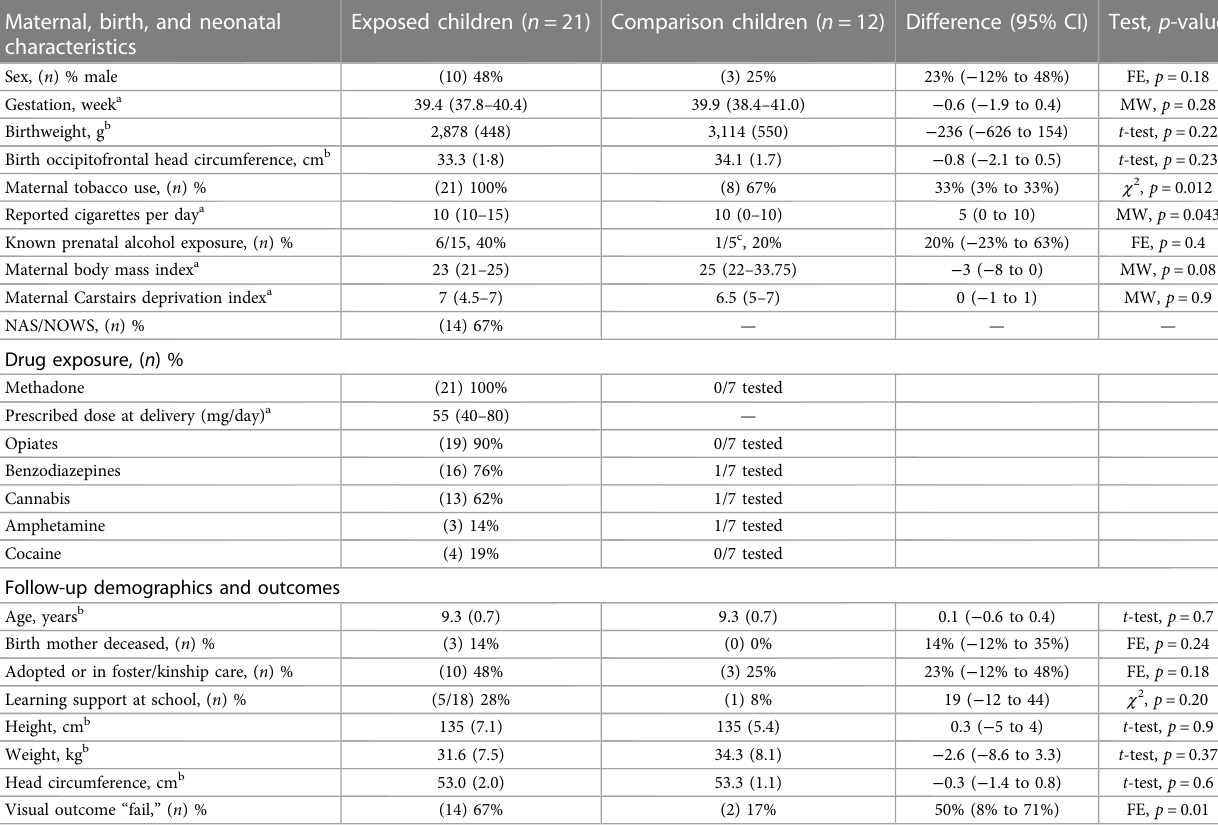
TABLE 1 Characteristics of exposed and comparison children. Maternal, birth, and neonatal characteristics